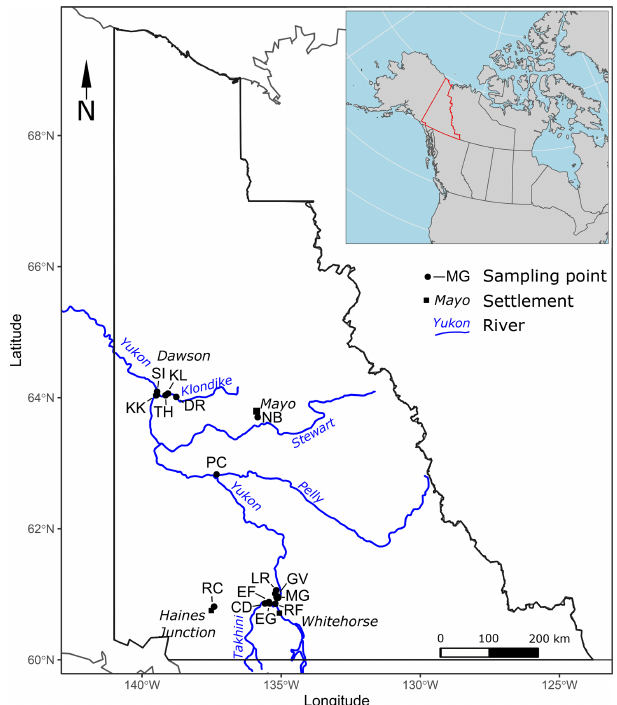
Figure 1. Map of the sampling locations and major rivers and set- tlements of the Yukon. Top right: the Yukon’s location (red) within North America